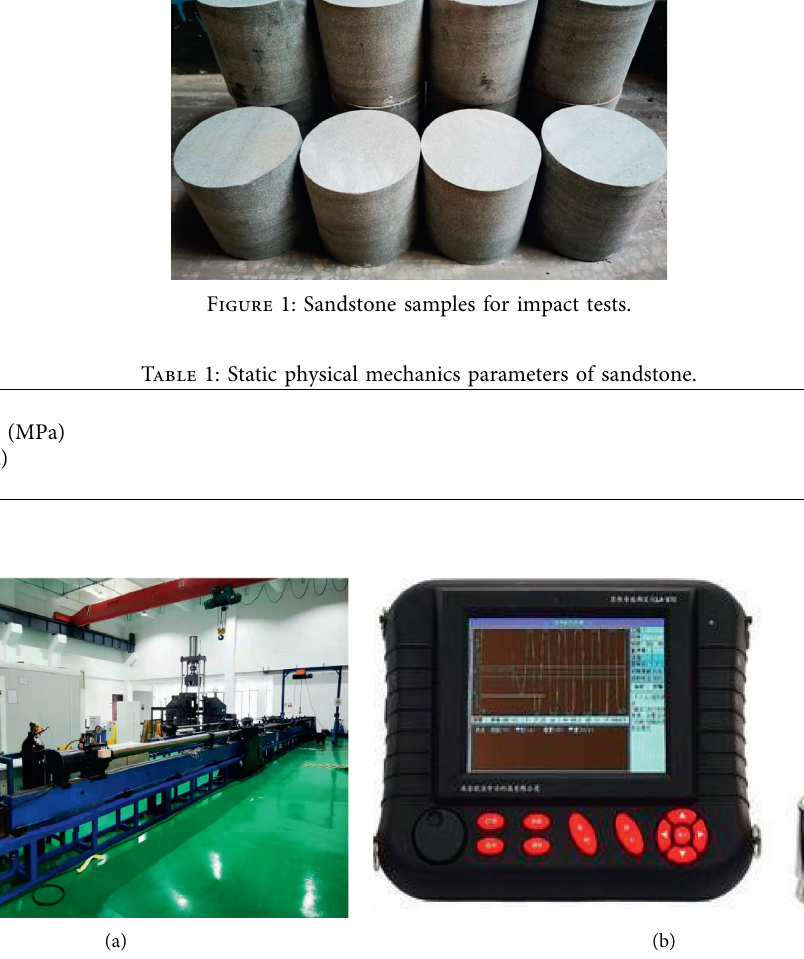
Figure 2: SHPB test facility system and rock sonic velocimeter. (a) SHPB test facility and (b) rock sonic